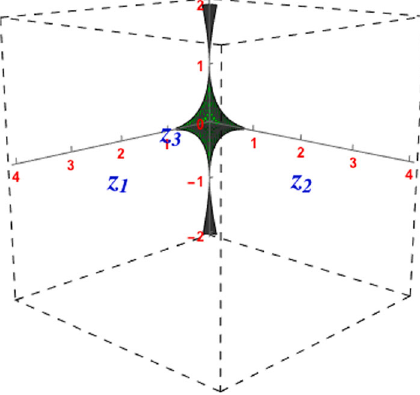
Fig. 4 Convergence regions of the r.h.s. of Eq. (10) (top and bottom | z | > 1 regions) and of Eq. (2) ( | z 3